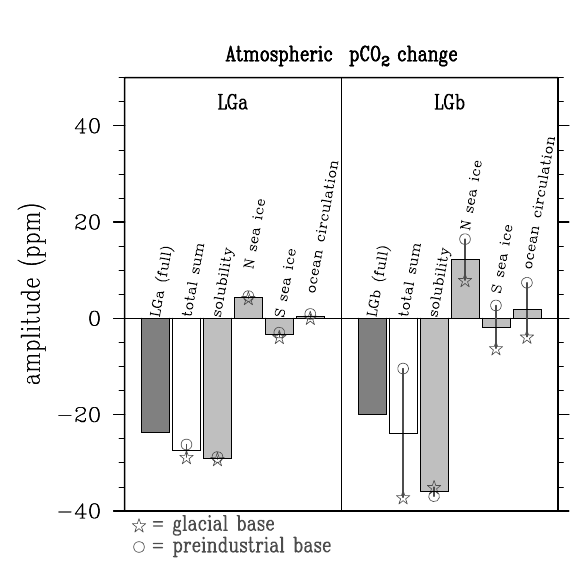
Fig. 9. Atmospheric p CO 2 responses to the climate dynamic changes. The left panel shows configuration “a” experiments, which switch on or off the climate factors of LGa. The right panel is the same in the left, but for configuration “b” experiments, switching on/off the climate factors of LGb. Thick bars refer to the average of two factorial estimates in the glacial and preindustrial climates (Table